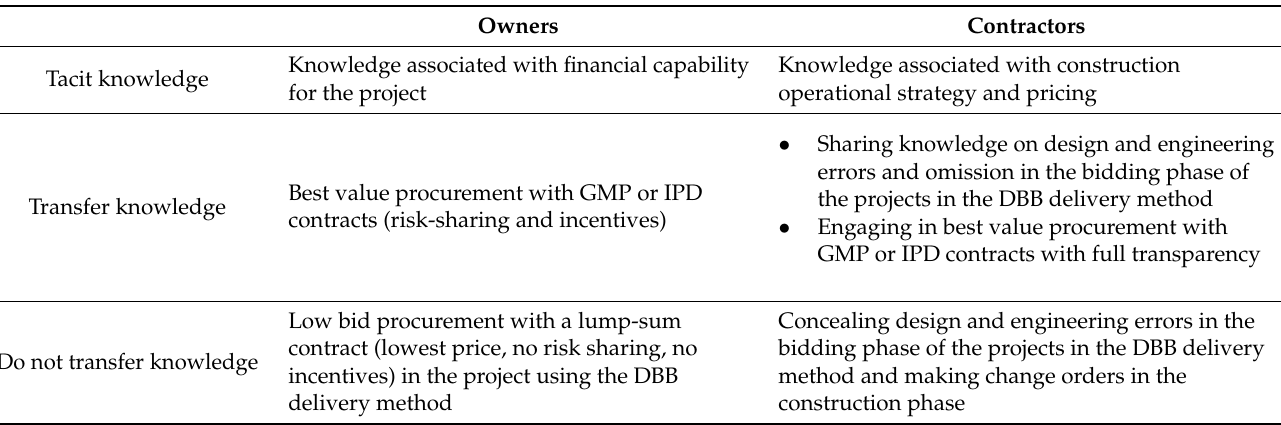
Table 2. Owners’ and contractors’ tacit knowledge sharing scenarios in construction projects.